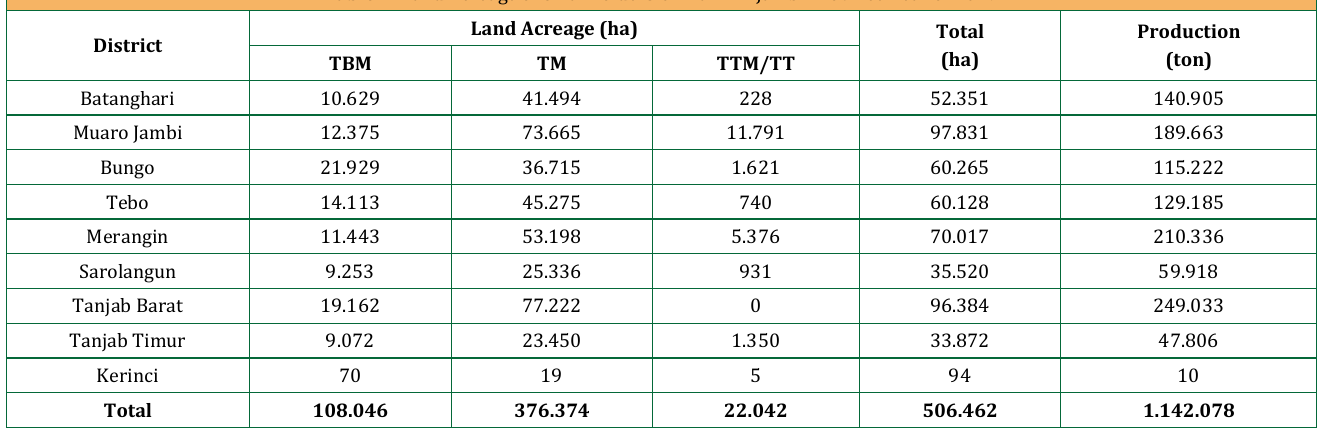
Table 2: Land Acreage of Smallholders Oil Palm in Jambi Province Year of 2019 District